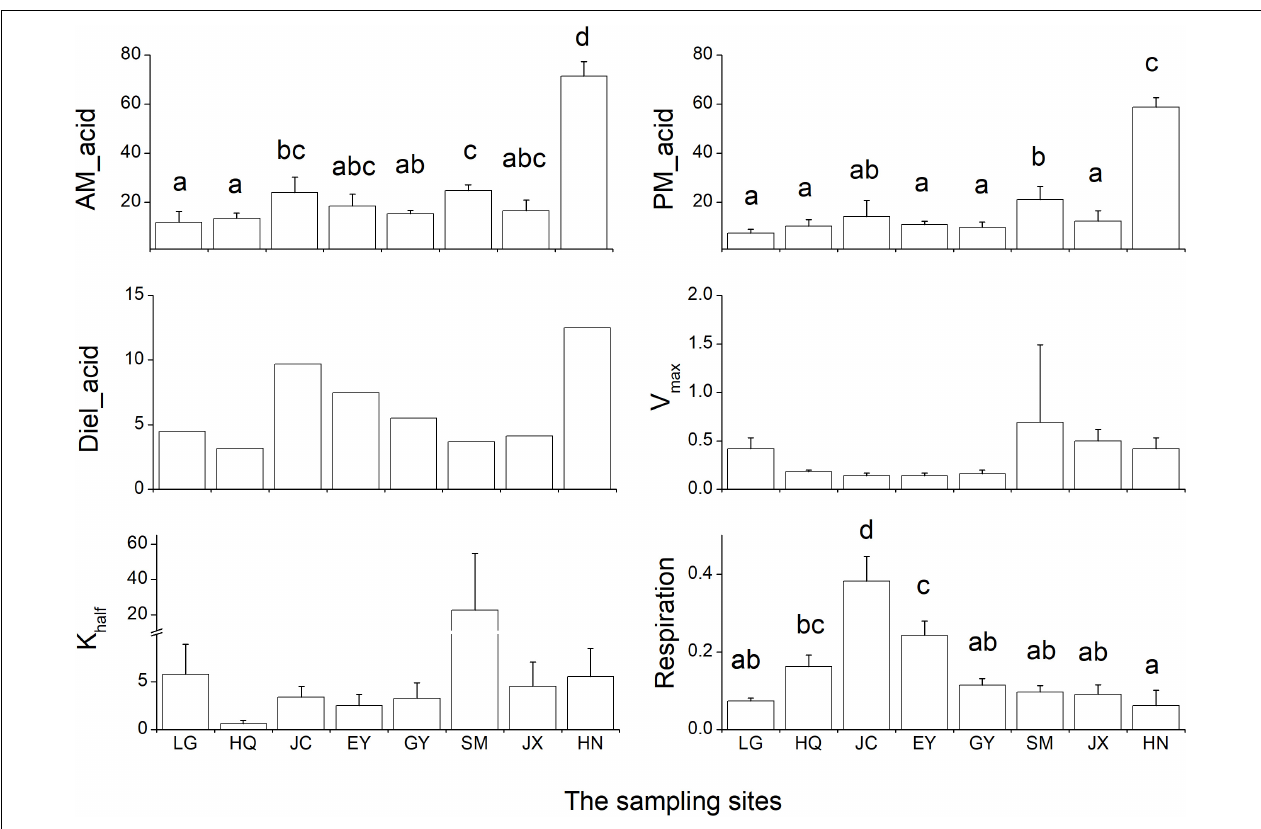
FIGURE 2 | The six carbon-related leaf traits in the eight Ottelia populations. AM_acid and PM_acid is the acidity of the leaves at ca. 7 am and 7 pm (unit: µ equiv g − 1 FW). Diel_acid is the changes between mean AM_acid and mean PM_acid (unit: µ equiv g − 1 FW). V max is the maximum rate of net photosynthesis (unit: mg O 2 g − 1 FW h − 1 ), and K half is the concentration of dissolved inorganic carbon producing half-maximal rates of net photosynthesis calculated from the Michaelis–Menten equation (unit: mM). Respiration is the respiration rate in the dark (unit: mg O 2 g − 1 FW h − 1 ). Due to the method of calculation, Diel_acid, V max and K half are not analyzed by ANOVA and therefore no statistical results for post hoc test. The different letters in the figure indicate the significant difference among the eight population.